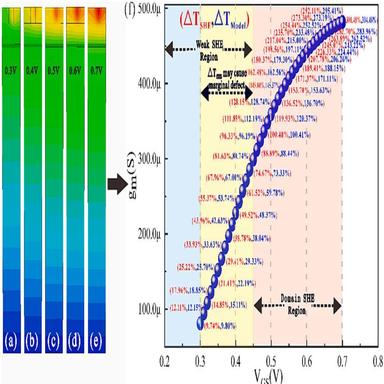
(a) - (e) The distribution of SHE within the transistor under different VGS; (f) The temperature difference between the model data and SHE data at different VGS.